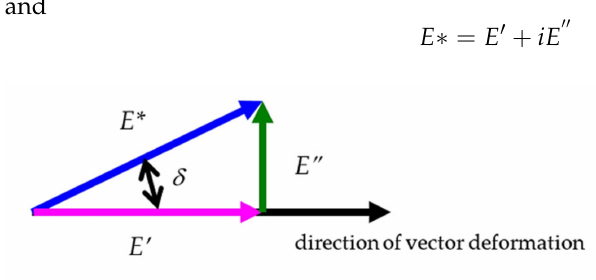
Figure 2. Schema of relations among